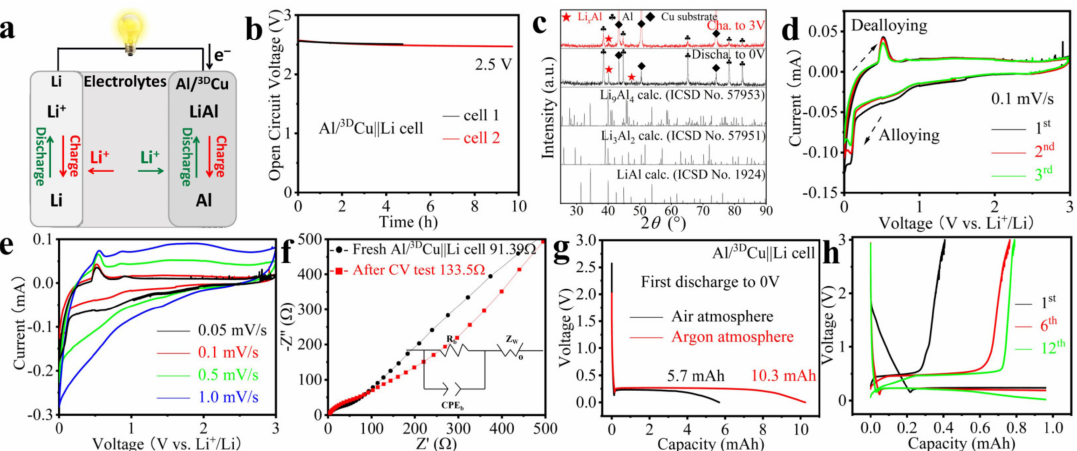
Figure 4. ( a ) Working principle of the Al/ 3D Cu||Li battery. The electrochemical performance of the Al/ 3D Cu electrode electrodeposited at − 1.70 V ( b , d – f ) or –1.85 V ( c , g , h ) and 90 ◦ C. ( b ) The stability curve of the open circuit voltage. ( c ) PXRD pattern comparison of discharged to 0 V at 4.2 mA g − 1 and charged to 3 V electrode at 21 mA g − 1 . ( d ) CV comparison between three cycles at 0.1 mV s − 1 and ( e ) different scan rate. ( f ) The EIS comparison between a fresh battery after about 4.7 h rest and the same battery after one CV cycle at 0.05 mV s − 1 (inset: the equivalent circuit for the simulation). ( g ) Galvanostatic first discharge curve to 0 V at 21 mA g − 1 . ( h ) Galvanostatic discharge–charge profiles for selected cycles at 21 mA g − 1